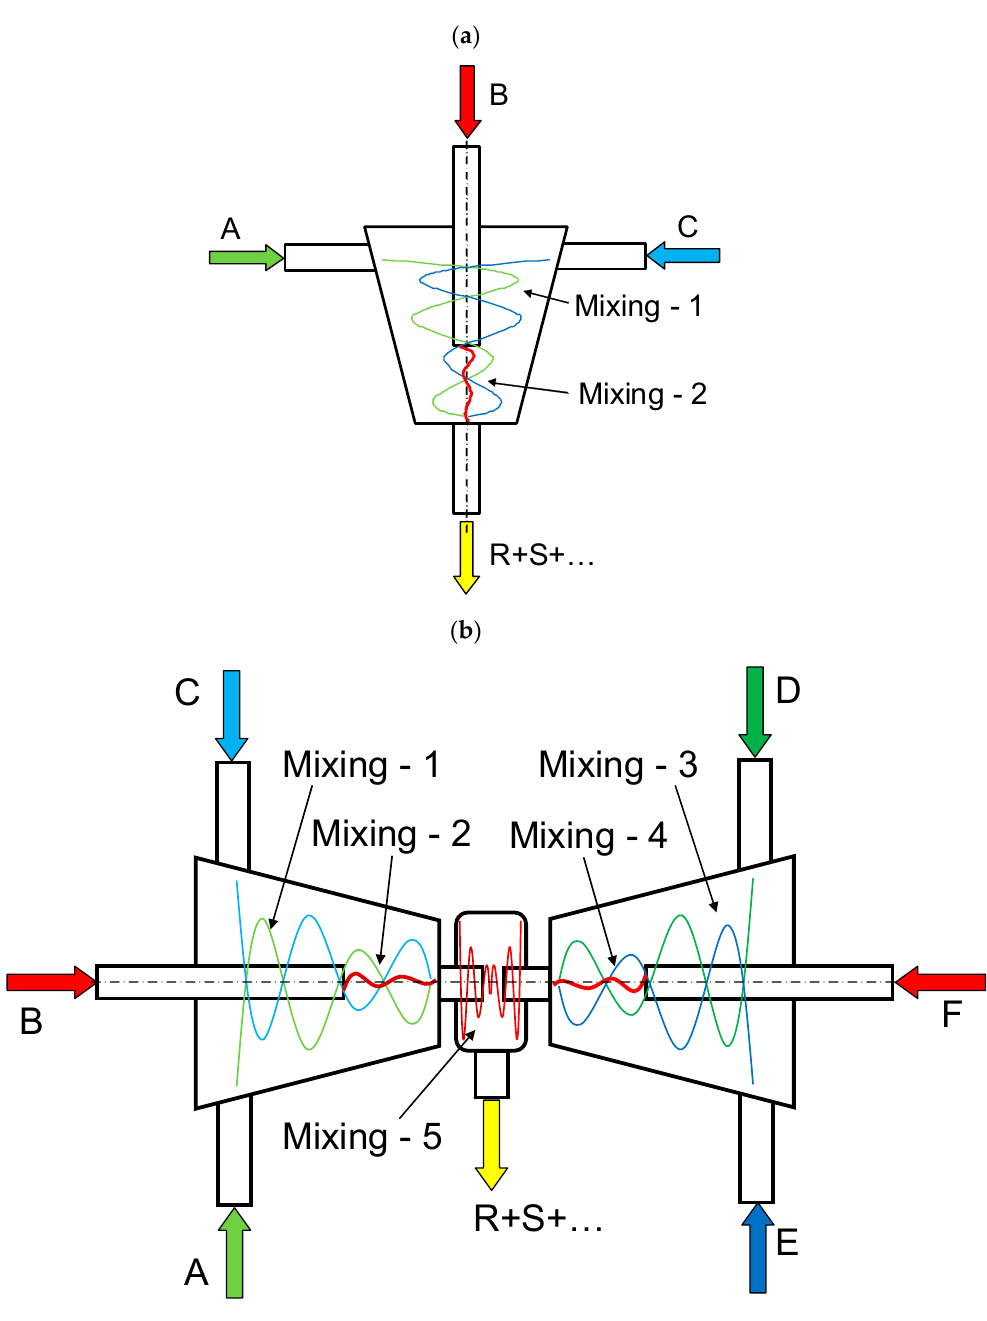
Figure 1. Schematic of the microreactor with intensively swirling flows: MRISF‑1 ( a ), MRCSF ( b ). In [11], the synthesis of calcium fluoride CaF 2 in a MRCSF was considered. Powders of calcium fluoride doped with ions of rare earth elements are luminophors and are used as precursors for optical ceramics.